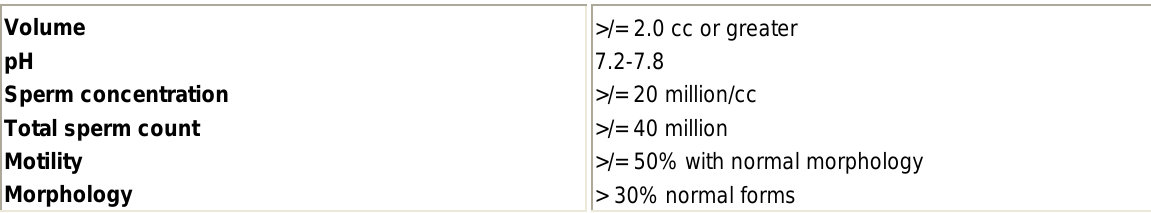
World Health Organization (WHO) Criteria For Normal Semen